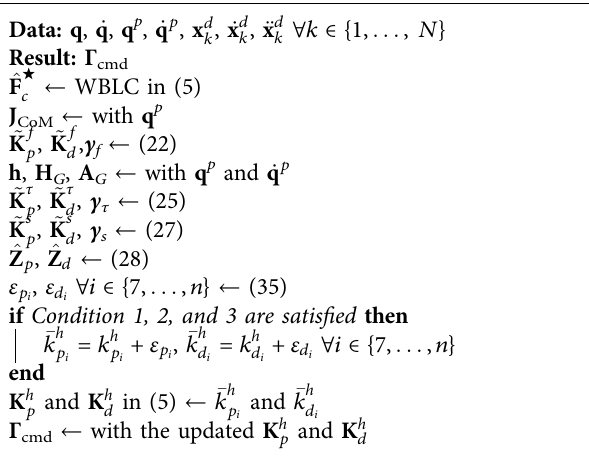
Algorithm 1. Proposed Gain Adaptation